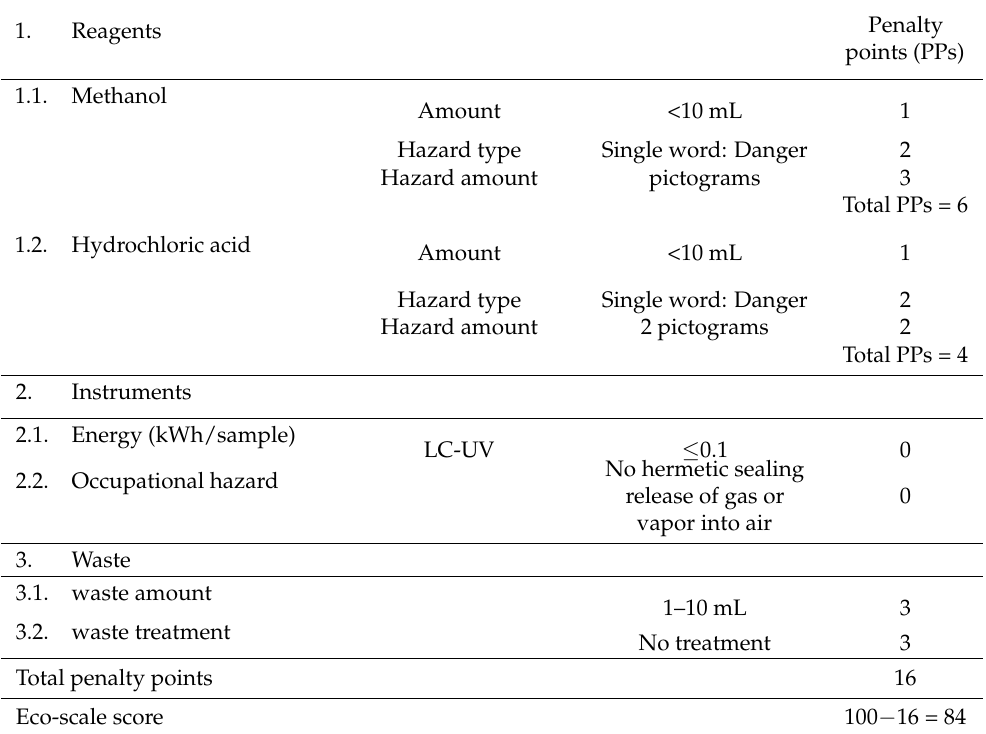
Table 4. The greenness profile of the developed MCR-ALS and PLSR chemometric methods employ- ing Eco-scale